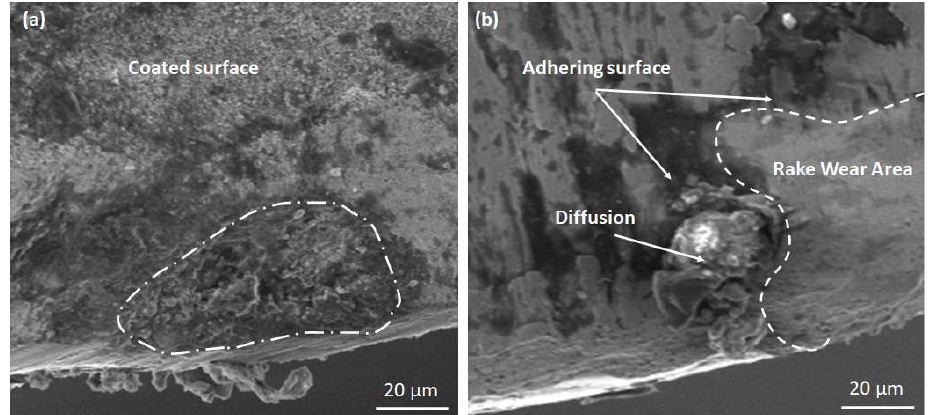
Figure 2. SEM images of tungsten carbide insert coated with TiAlSiN cryogenic treated for 36 h ( a ) before machining and ( b ) after machining.